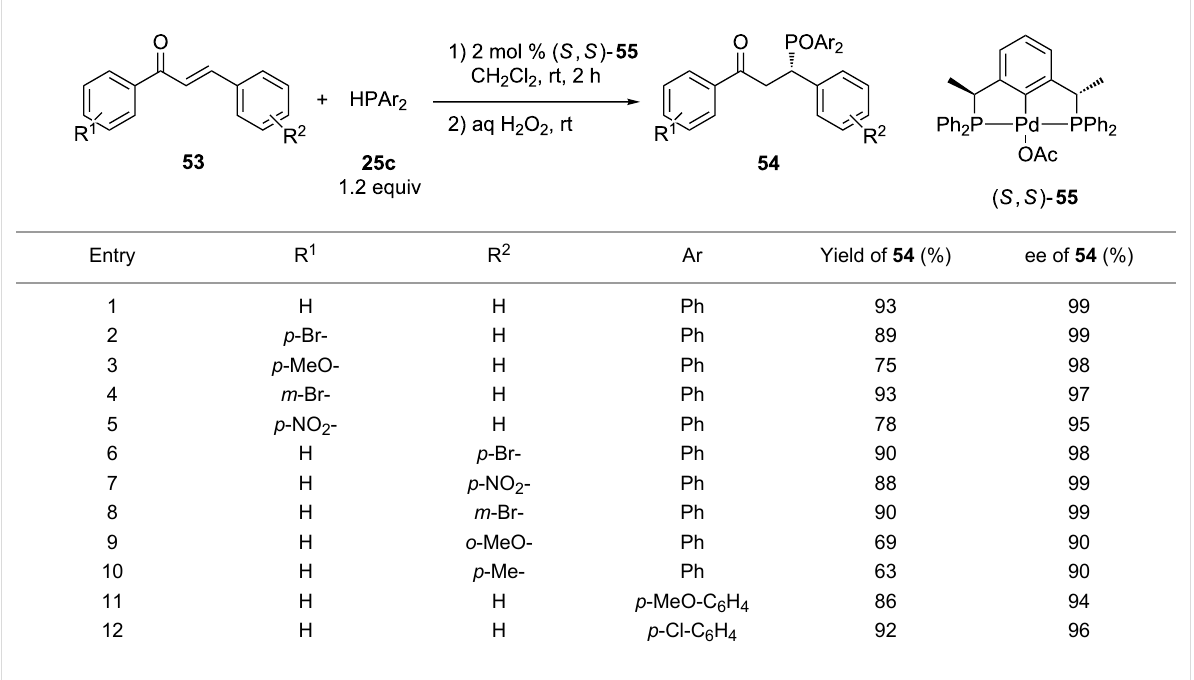
Table 4: Palladium-catalyzed asymmetric addition of diarylphosphines 25c to enones 53